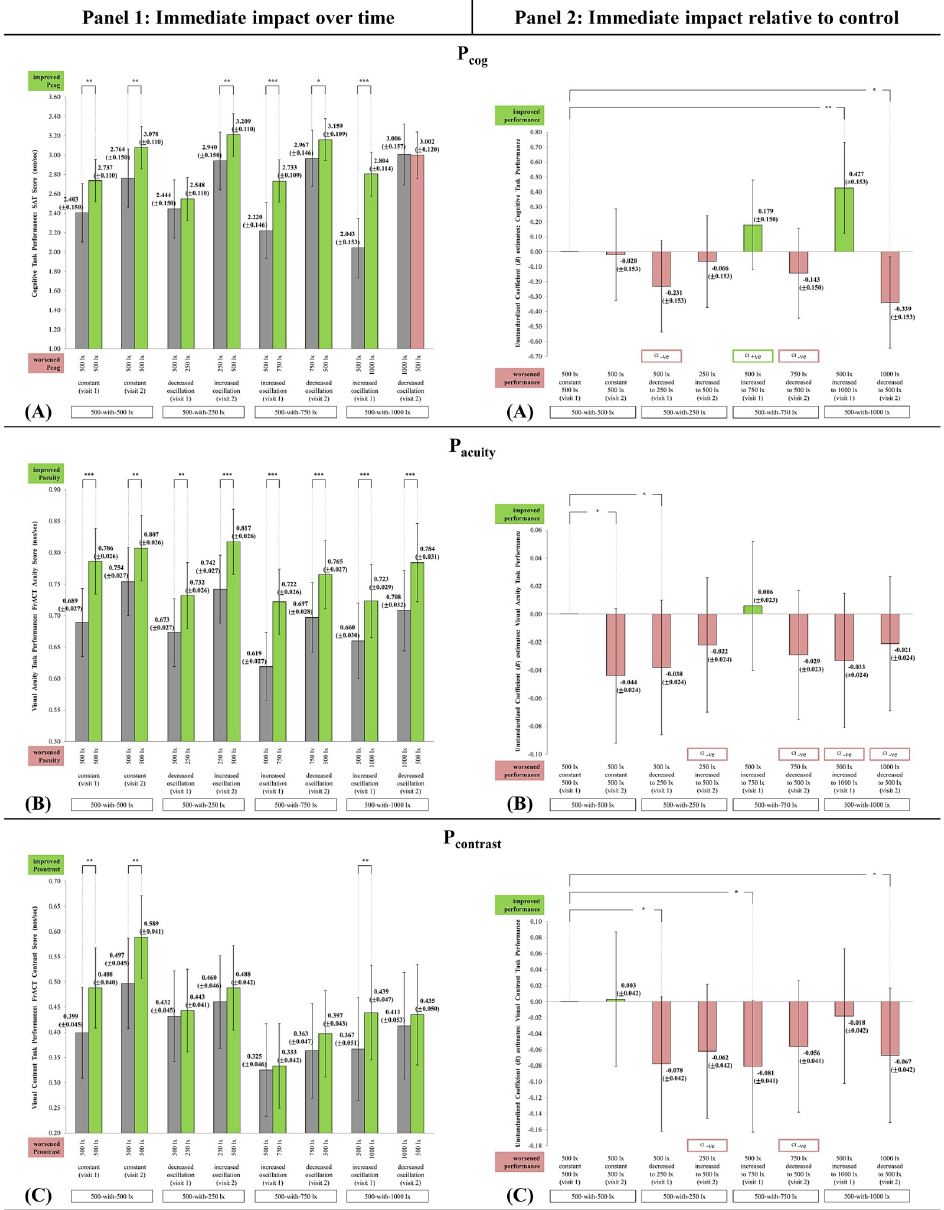
Fig 8. The immediate impact observed in P cog , P acuity , and P contrast across the light-settings. (A) P cog . (B) P acuity . (C) P contrast . (8A–8C, panel 1) Immediate change over time in all light-settings: Bars represent Estimated Marginal Means (EMM) with Standard Errors (SE); whiskers 95% confidence interval (CI); ��� p < 0.001, �� p < 0.01, � p < 0.05, ^ p < 0.06. Dark grey bar specifies EMM at TP 1 . Green bar specifies EMM at TP 2 (supportive change). Red bar specifies EMM at TP 2 (unsupportive change). (8A–8C, panel 2) Immediate impact of each light-setting relative to control: Bars represent Unstandardized Coefficient ( B ) with Standard Errors (SE); whiskers 95% CI; ��� p < 0.001, �� p < 0.01, � p < 0.05, ^ p < 0.06. Green bar specifies light-setting as more supportive than control. Red bar specifies light-setting as less supportive than control. (S2 Fig) The chronological order of each light-setting’s EMM Δ for P cog , P acuity , and P contrast . It is recommended to be referred along with Figs 8A–8C to improve the comprehension between panel 1 and 2. Light-setting with EMM Δ chronologically ordered above than the control (S2 Fig) corresponds with the direction of the B estimate bar as being more supportive than control (Figs 8A–8C, panel